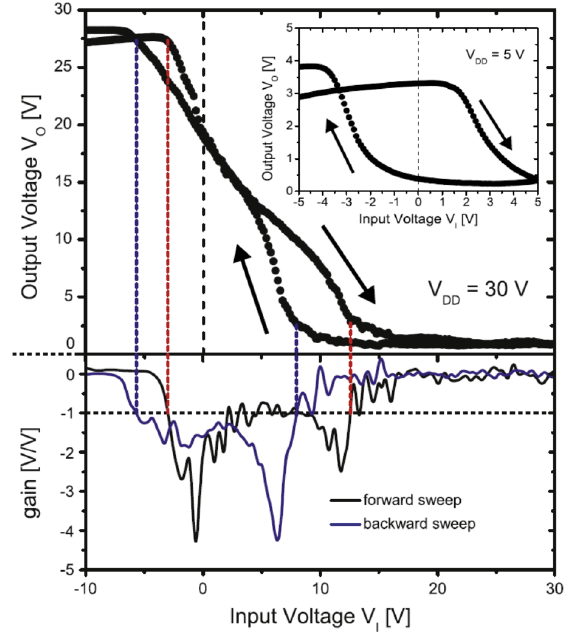
Figure 20. Voltage transfer characteristics of a ZnO based inverter. Reprinted from [76], with permission from